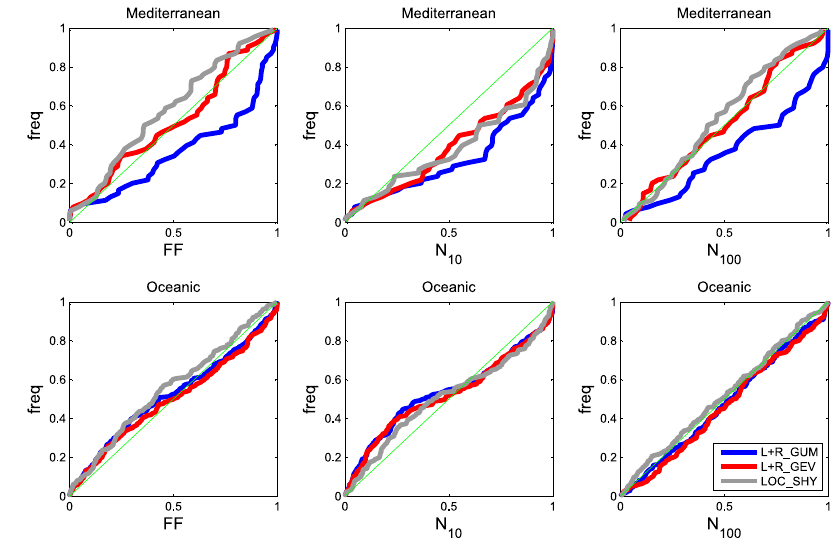
Fig. 7. Reliability indices for Mediterranean (top) and Oceanic (bottom) catchments.